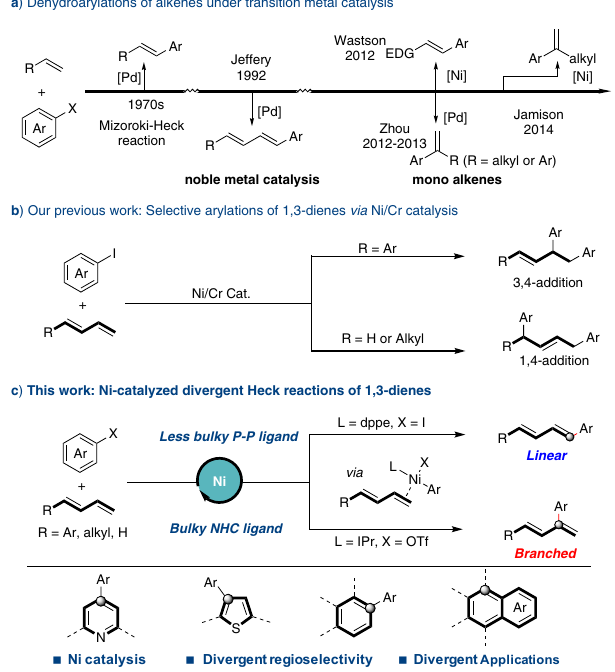
Fig. 1 | Transition metal-catalyzed arylations of 1,3-dienes. a Dehydroarylations of alkenes under transition metal catalysis. b Our previous work: Selective aryla- tions of 1,3-dienes via Ni/Cr catalysis. c This work: Ni-catalyzed divergent Heck reactions of